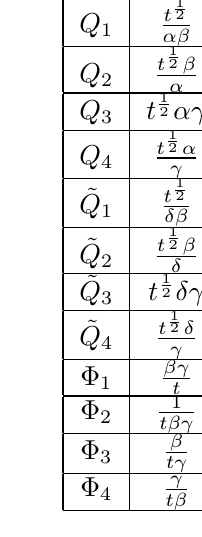
Figure 3 . On the left is the quiver diagram for the theory one gets when gluing together two free trions along all maximal punctures for k = 2. On the right is a table summarizing the charges of the (cid:12)elds under all the non R -symmetries: the internal u (1) (cid:12) ; u (1) (cid:13) ; u (1) t , and the minimal puncture ones u (1) (cid:11) ; u (1) (cid:14) . Additionally there is a cubic superpotential for every triangle. Alternatively it is given by the most general cubic superpotential that is gauge invariant and consistent with the symmetry allocation in the table. All (cid:12)elds have the free R -charge 2 3